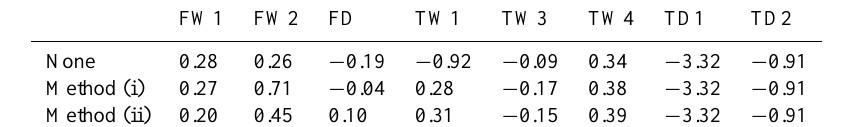
Table 2. The maximum objective function values of GLUE experiment, with GPP module off, GPP calculated by method (i), and GPP calculated by method (ii).